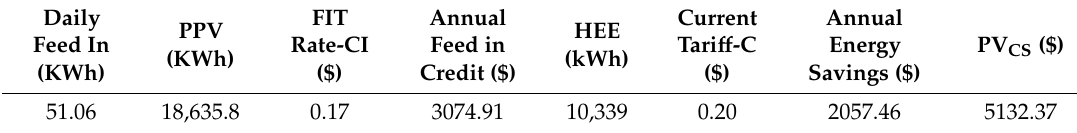
Table 6. Photovoltaic plant installation (USA-California).